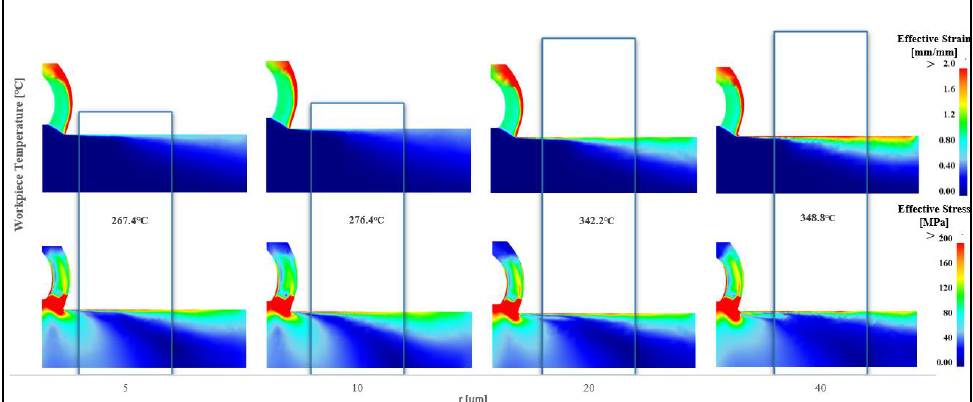
Figure 8. Maximum workpiece temperature–strain–stress simulations with respect to the edge ra- dius.